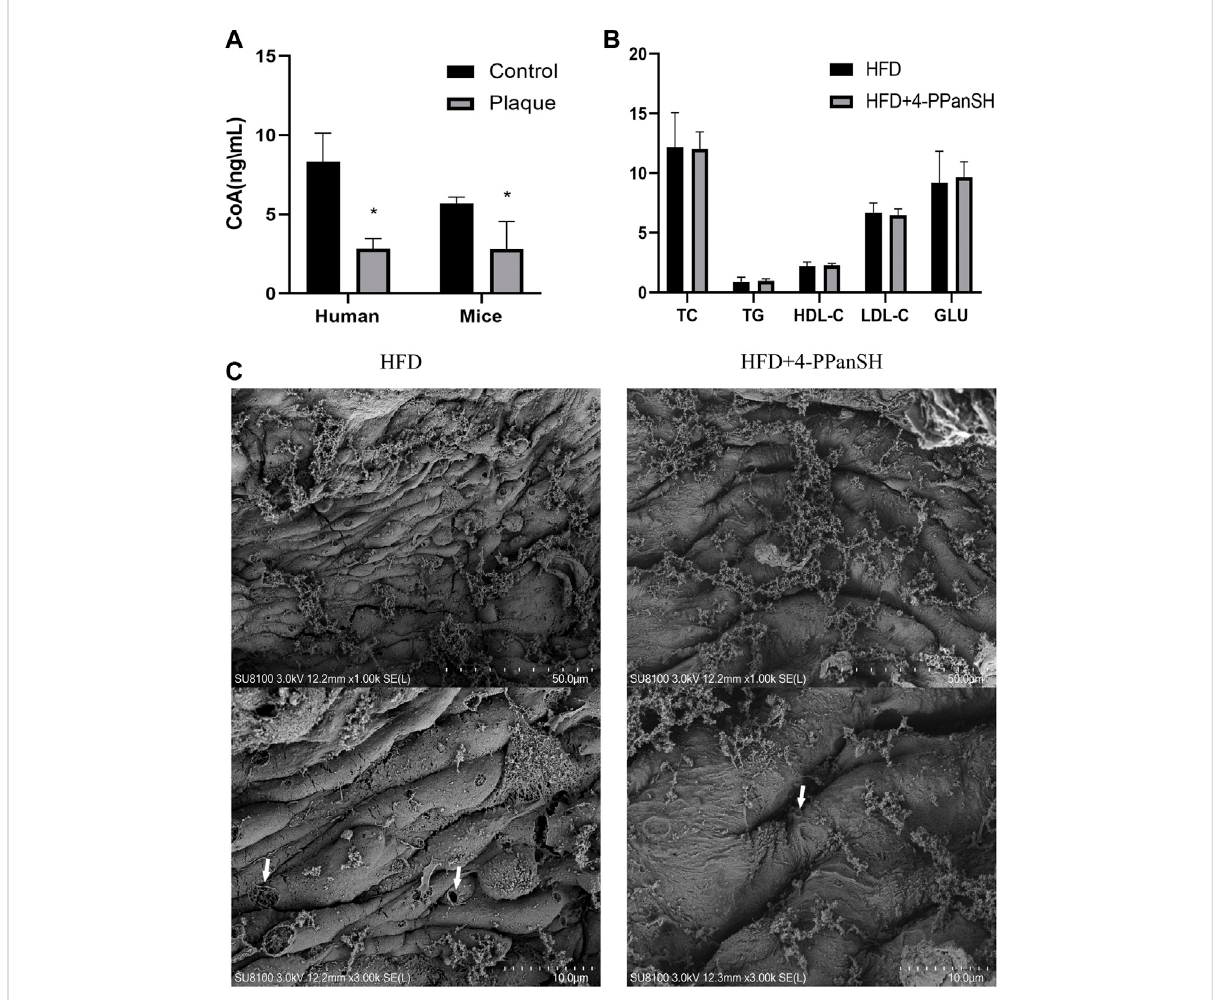
FIGURE 5 4-PPanSH could attenuate vascular endothelial injury. (A) The CoA content in plaques of human rigidi fi ed arteries and the abdominal aortas of mice were detected by HPLC-MS and the surrounding normal vascular tissues were used as controls ( n = 3). CoA in atherosclerotic plaque